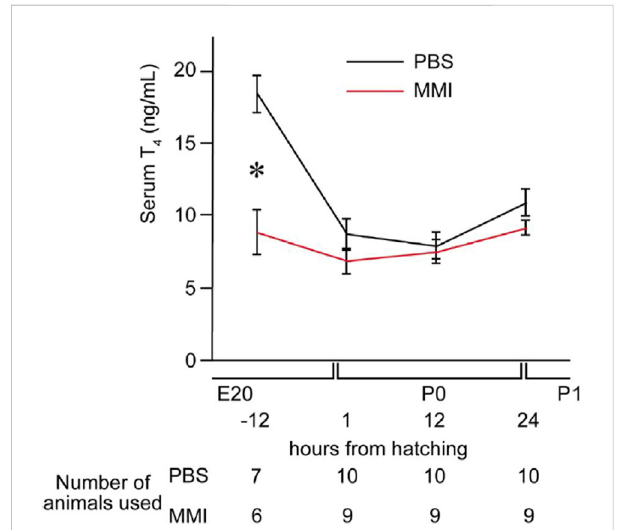
FIGURE 2 Effects of methimazole (MMI) injection on the concentrations of T 4 in the serum. We measured T 4 concentration in the serum 12 h beforehatching(externalpipping)andat1,12,and24 hafterhatching. At 12 h before hatching, T 4 concentrations in the serum of MMI- administered chicks were signi fi cantly lower than those of PBS- administered chicks. However, the T 4 concentrations did not differ between the two groups at the other three time points. Data are presented as the mean ± SEM. Asterisks (*) indicate signi fi cance ( p < 0.05).